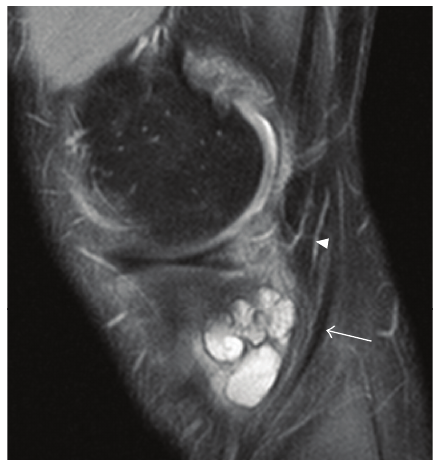
Figure 2: Pes anserine bursitis. Sagittal proton density fat-saturated image of the medial aspect of the left knee in a 47-year-old male floor layer. Arrow, semitendinosus tendon; arrow head, semimembranosus